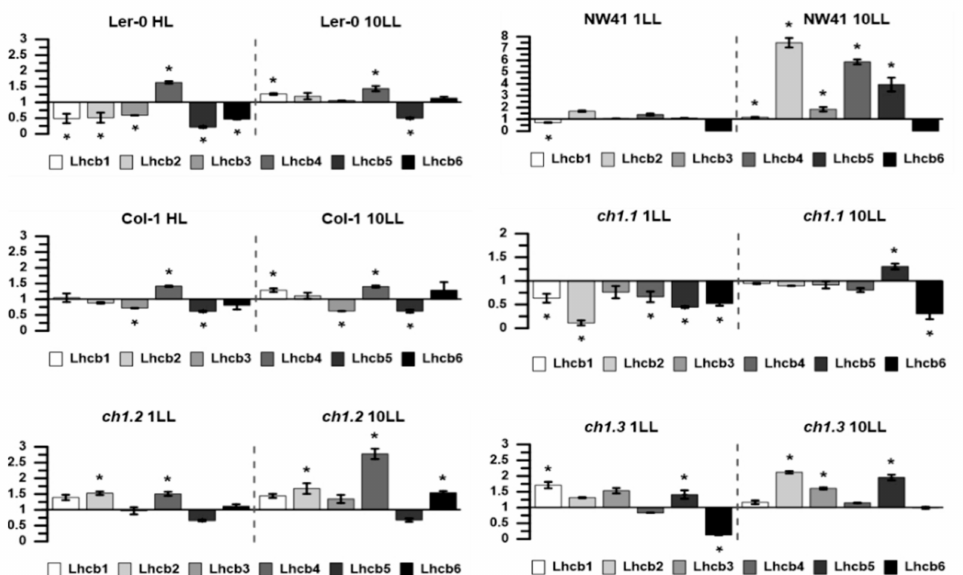
Figure 2. Relative optical density of Lhcb1-6 proteins isolated from NW41, ch1.1, ch1.2 , ch1.3 , Ler-0 and Col-1 Arabidopsis plants in LL (low-light) and HL (high-light) conditions; in reference to NL (normal light) conditions; 1LL, 10LL—after 1st and 10th day of treatment. The data were obtained from immunoblot analysis of SDS-PAGE gels with 2 µ g of total chlorophyll per well. Presented data are mean values ± SD from 3 independent experiments; pairs of results marked with an asterisk differ significantly at p = 0.05 (one-way ANOVA with the post hoc Tukey